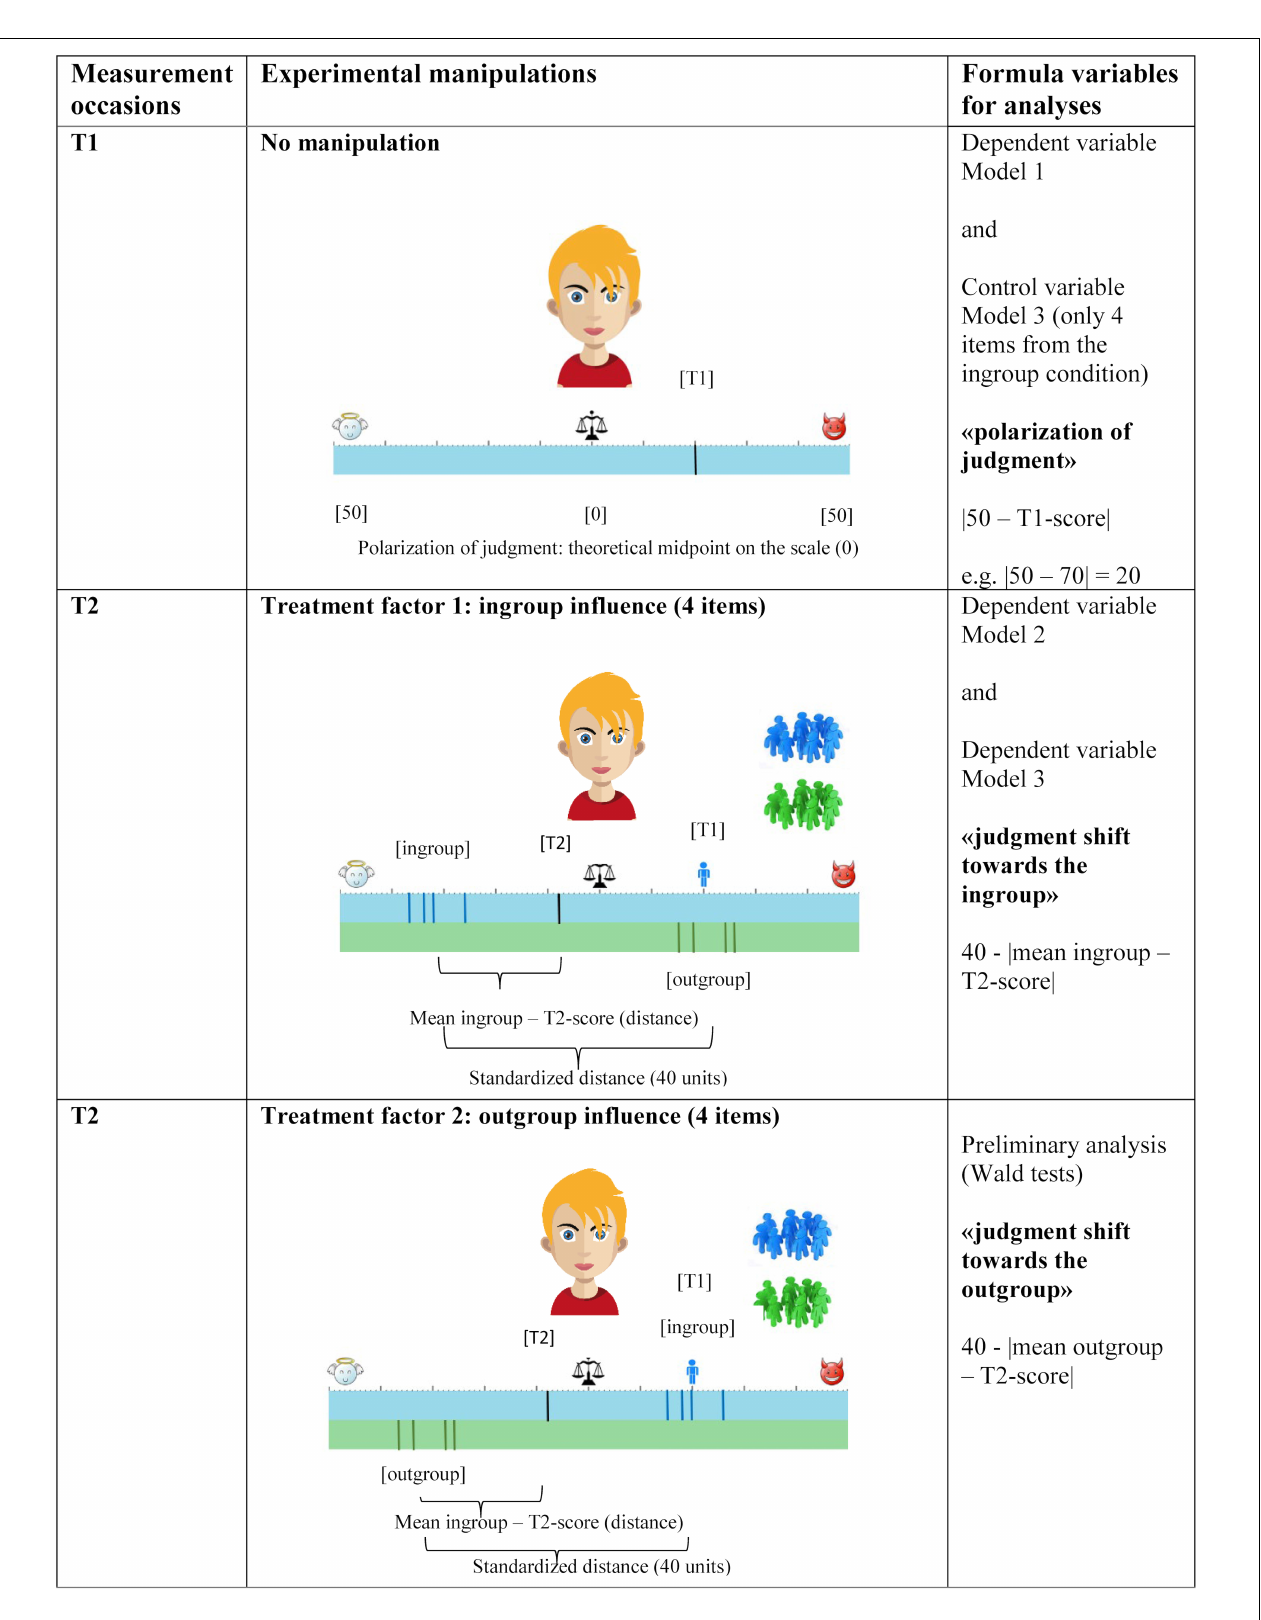
FIGURE 1 | Overview on the experiment over the two measurements occasions. Picture source: Freepik (2020).